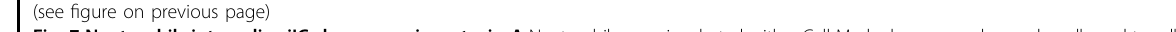
Fig. 7 Neutrophils internalize iICs by macropinocytosis. A Neutrophils were incubated with a Cell Mask plasma membrane dye, allowed to adhere to glass coverslips and imaged using an Andor Revolution XDi spinning disc confocal microscope with 60× objective, acquiring roughly 2 images per minute. At time 0 cells were stimulated with fl uorescently labelled iICs. Stills depict a single cell taken at the indicated timepoint are shown (see also Supplemental Movie 1). * denotes areas of abundant plasma membrane stain (likely ruf fl ing) following stimulation; arrows identify internalized iICs. Arrowheads, loss of internalized iIC-associated fl uorescence in the plasma membrane-derived vacuole. B Neutrophils were stimulated with 2 μ g/ml iICs or 5 beads/neutrophil in the presence of the fl uid phase marker lucifer yellow. Representative confocal images of neutrophils that had ingested iICs (top and middle) or beads (bottom) and in which PI3K had (middle) or had not (top, bottom) been inhibited. Arrowheads, lucifer yellow internalization that accompanied phagocytosis. A , B Scale bars, 2 μ m. Pinocytosis was assessed by uptake of lucifer yellow with neutrophils ( C ) that had been stimulated with vehicle, iICs, components thereof (HSA and anti-HSA) or Fc γ R blocking antibodies (AT10, 3G8) or ( D ) that had been pre-incubated with small molecule inhibitors as indicated (Chqu chloroquine, DPI diphenyleneiodonium, wort wortmannin, EIPA ethylisopropylamiloride) prior to stimulation with iICs. C , D Cells that had undergone macropinocytosis (i.e., taken up lucifer yellow) were counted. Each symbol represents the average value obtained in a separate experiment. Raw data were subjected to analysis by one-way ANOVA with multi comparison post-hoc test; * p <0.05; ** p <0.01; *** p <0.001.